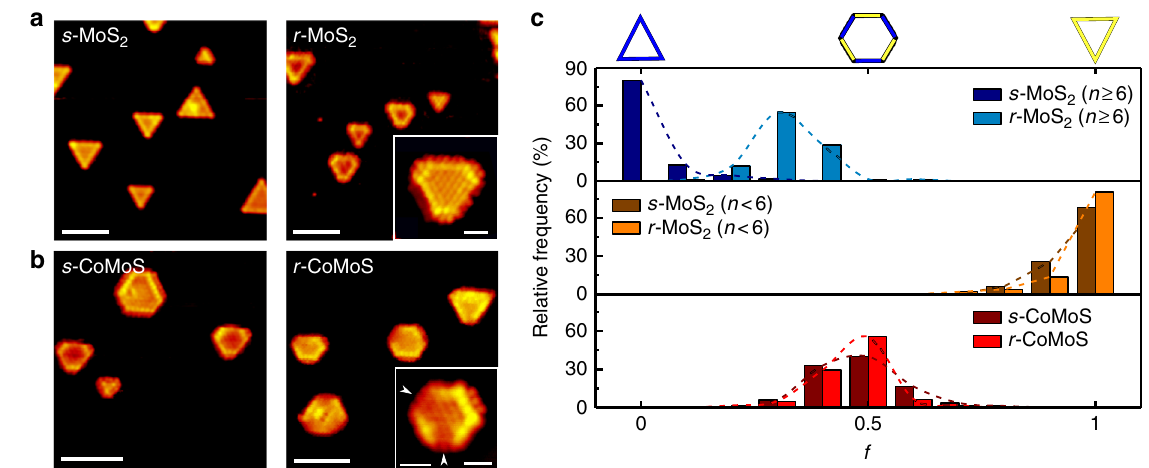
Fig. 2 Analysis of hydrogen-induced reshaping of MoS 2 and CoMoS. a The morphology of sul fi ded ( s -MoS 2 ) and reduced ( r -MoS 2 ) MoS 2 nanoclusters, insert showing high-resolution image of a r -MoS 2 cluster and b the morphology of sul fi ded ( s -CoMoS) and reduced ( r -CoMoS) CoMoS nanoclusters, insert showing high-resolution image of r -CoMoS cluster and white arrows point toward the quenched S-edges. All scale bars of the main images are 4 nm, the scale bar of the inserts are 1 nm. c Histograms of the shape factor ( f = l S / l total ) for sul fi ded and reduced MoS 2 and CoMoS structures. Mo-edge terminated ( n ≥ 6) and S-edge terminated ( n < 6) MoS 2 nanoclusters are plotted separately. The histograms were obtained from analysis of atom-resolved STM images of individual MoS 2 and CoMoS nanoclusters (number of clusters evaluated: s -MoS 2 ( n ≥ 6): 172, r -MoS 2 ( n ≥ 6): 66, s -MoS 2 ( n < 6): 94, r -MoS 2 ( n < 6): 51, s -CoMoS: 85, r -CoMoS 2 : 61. For further statistical details, see